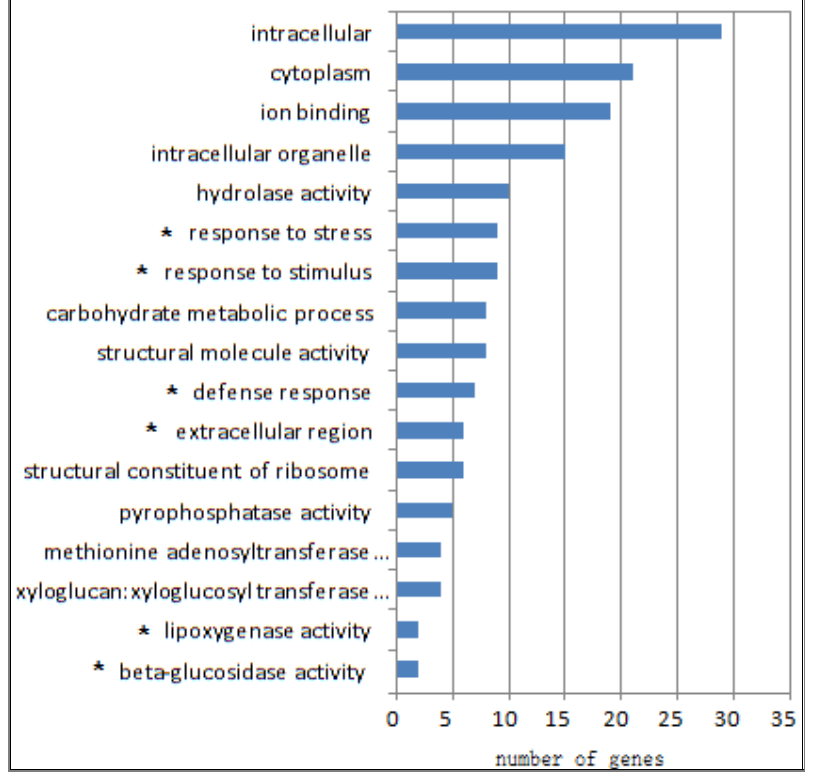
Figure 1. Differentially expressed genes in eibi1 according to gene